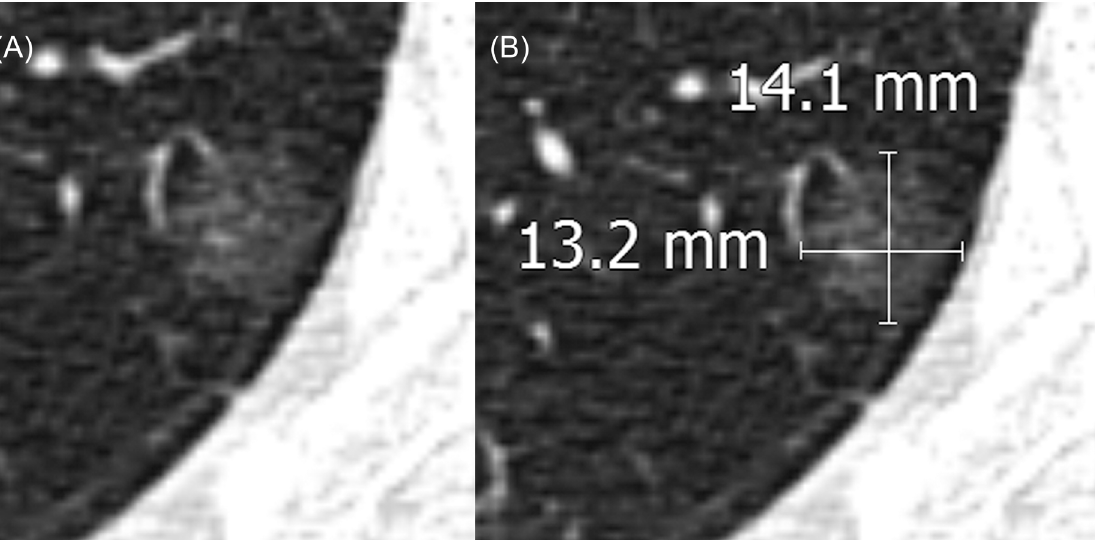
Fig 1. A pure ground-glass nodule in the right upper lobe of the lung in a 73 year-old female. (A) The subsolid nodule has a less distinct margin than the solid nodule. (B) The longest diameter along with its maximum perpendicular diameter was measured. Longest diameter measurement differences between scans ranged from -1.8 to 1.3 mm when the follow-up CT reader was different from that at initial